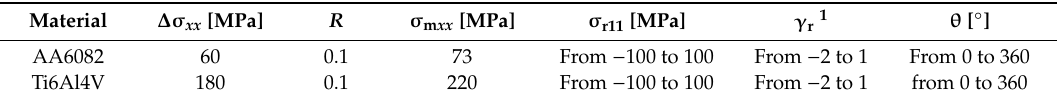
Table 2. Ranges of residual stress system modelled for AA6082 and Ti6Al4V alloys.